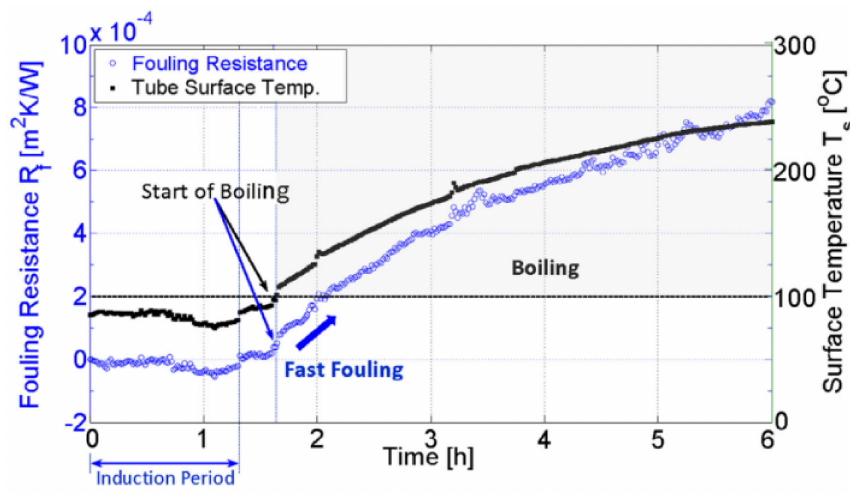
Figure 13. Change of fouling resistance during single-phase and two-phase